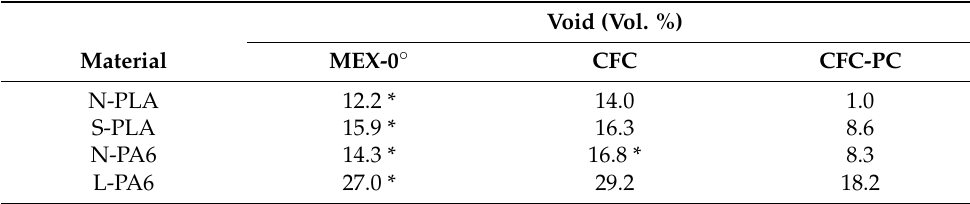
Table 6. Influence of rapid consolidation on void reduction in CFC specimen. For reference, the void volume fraction of the corresponding MEX specimen with a raster angle of 0 ◦ is